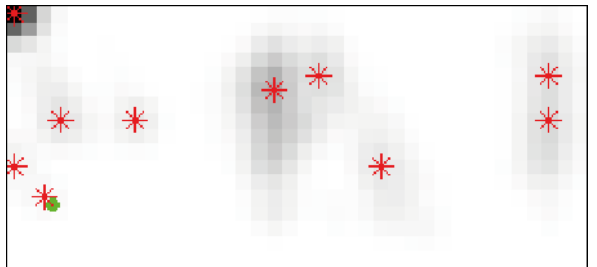
Figure 5: An example of the occurrence histogram of tests with the house data set. The correct solution (green) does not appear as a clear peak among the ten maxima (red) causing the method to fail in ≈ 60% of all tests based on nested clustering. Abscissa: 3D rotation angle; ordinate: 3D translation.